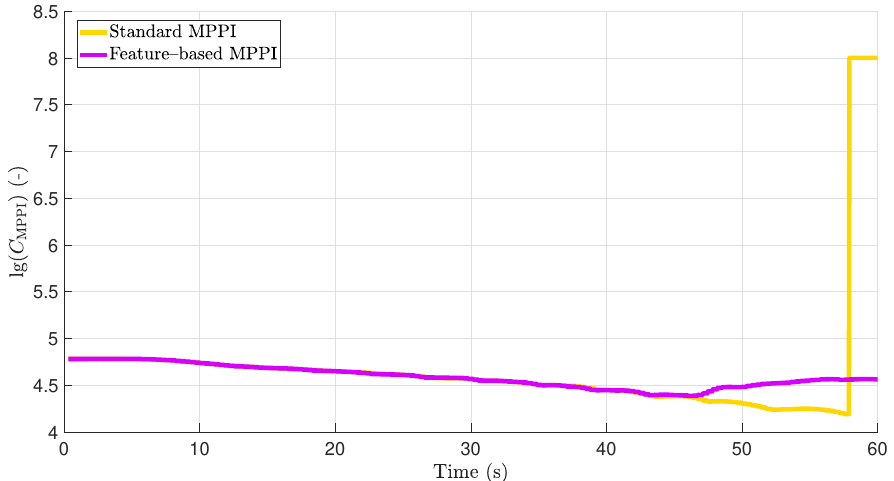
Figure 12. Comparison of costs plotted over time in full-scale experiments. Note the logarithmic representation of the